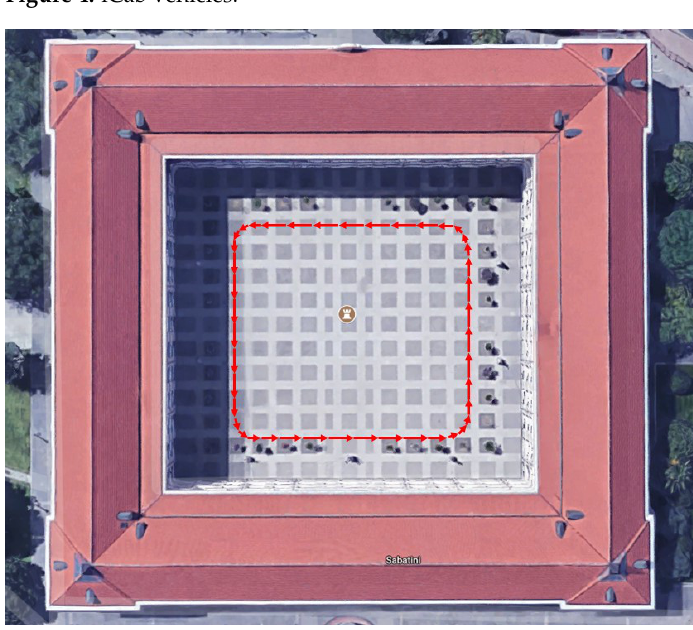
Figure 4. iCab vehicles.